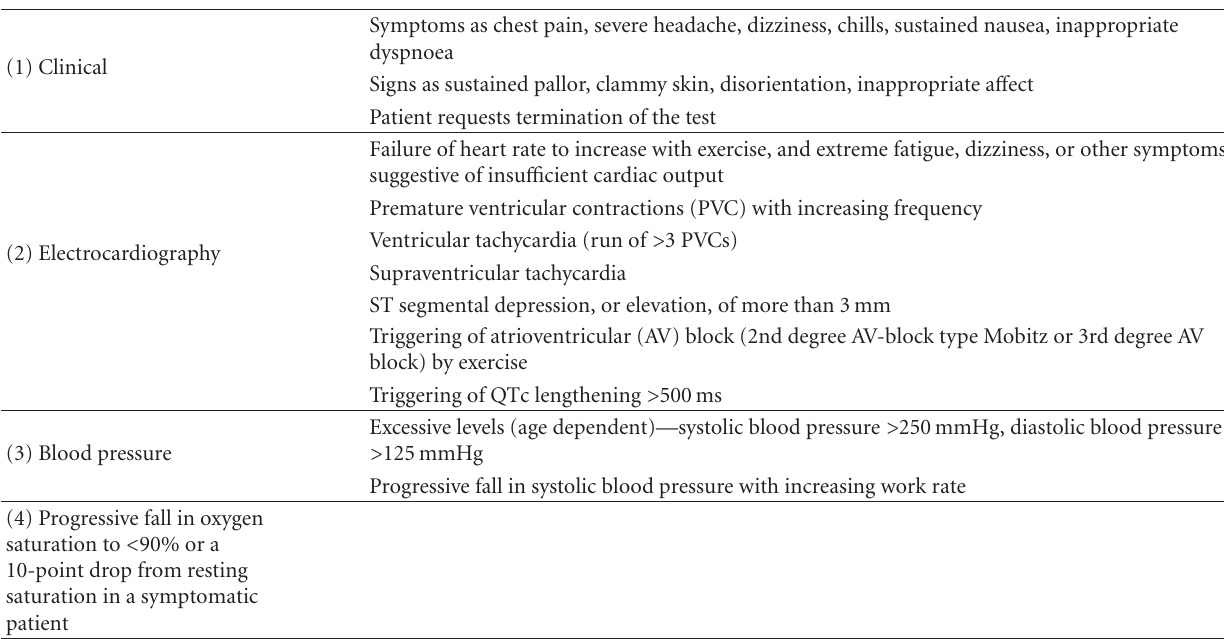
Table 2: Criteria for terminating exercise testing in children with CHD.